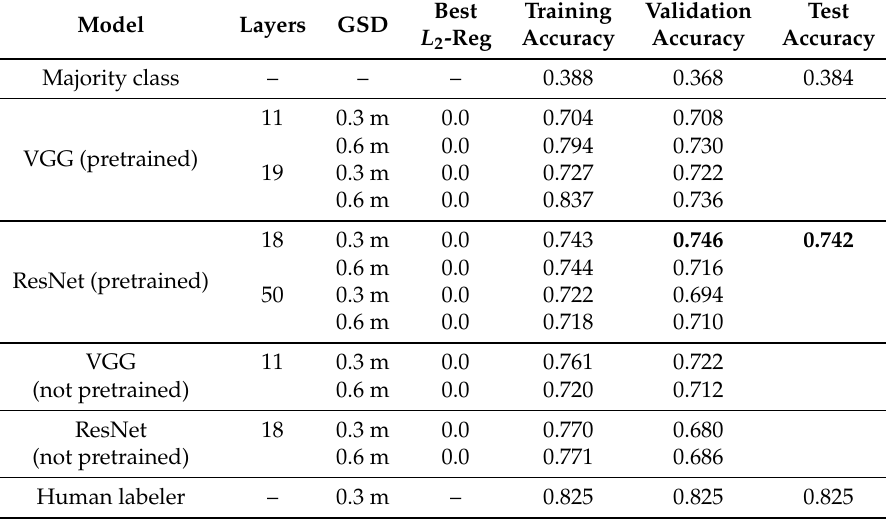
Table A2. In-field model selection. VGG and ResNet training and validation accuracies are shown for 12 architecture and hyperparameter settings. Comparisons to guessing everything is in the majority class (not in field) and human labeler accuracy are provided to gauge task difficulty and lower/upper bounds for metrics. Test accuracy was computed for the model with highest validation